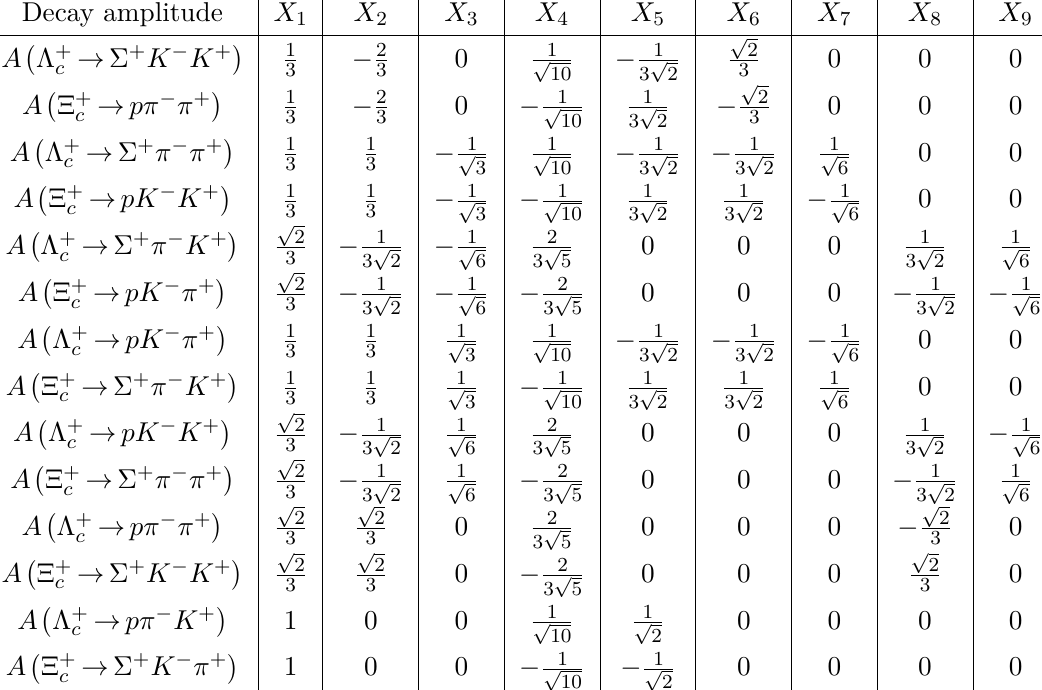
Table 9 . RME decomposition of C b → L b P − P + amplitudes up to first order U -spin breaking ( b = 0 and b = 1 ). The corresponding RMEs X are defined in eq. (H.1). α all 20 RMEs is equal to 13 thus resulting in one sum rule that holds at order b = 2 .